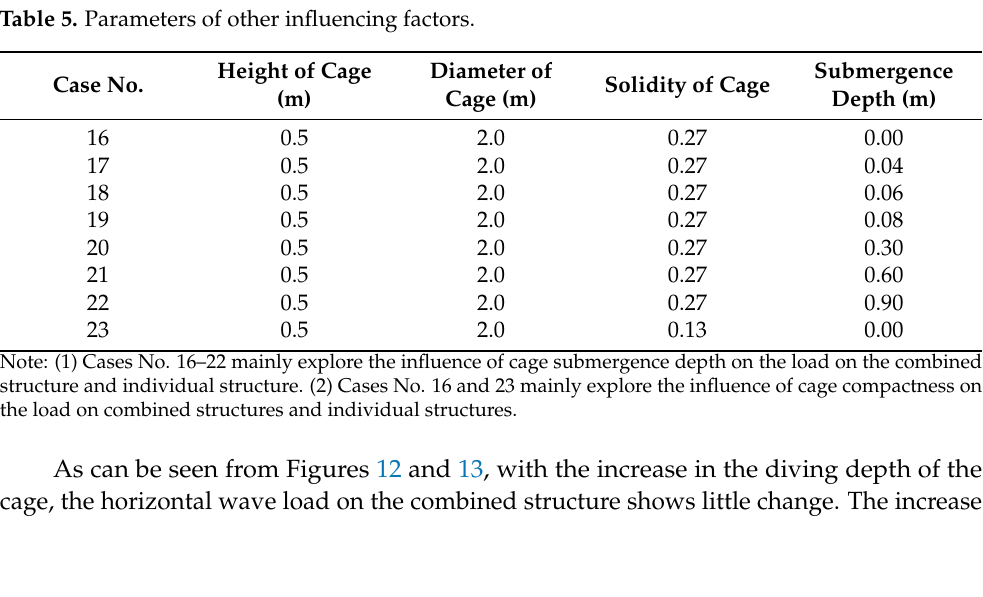
and diameters ( b ).